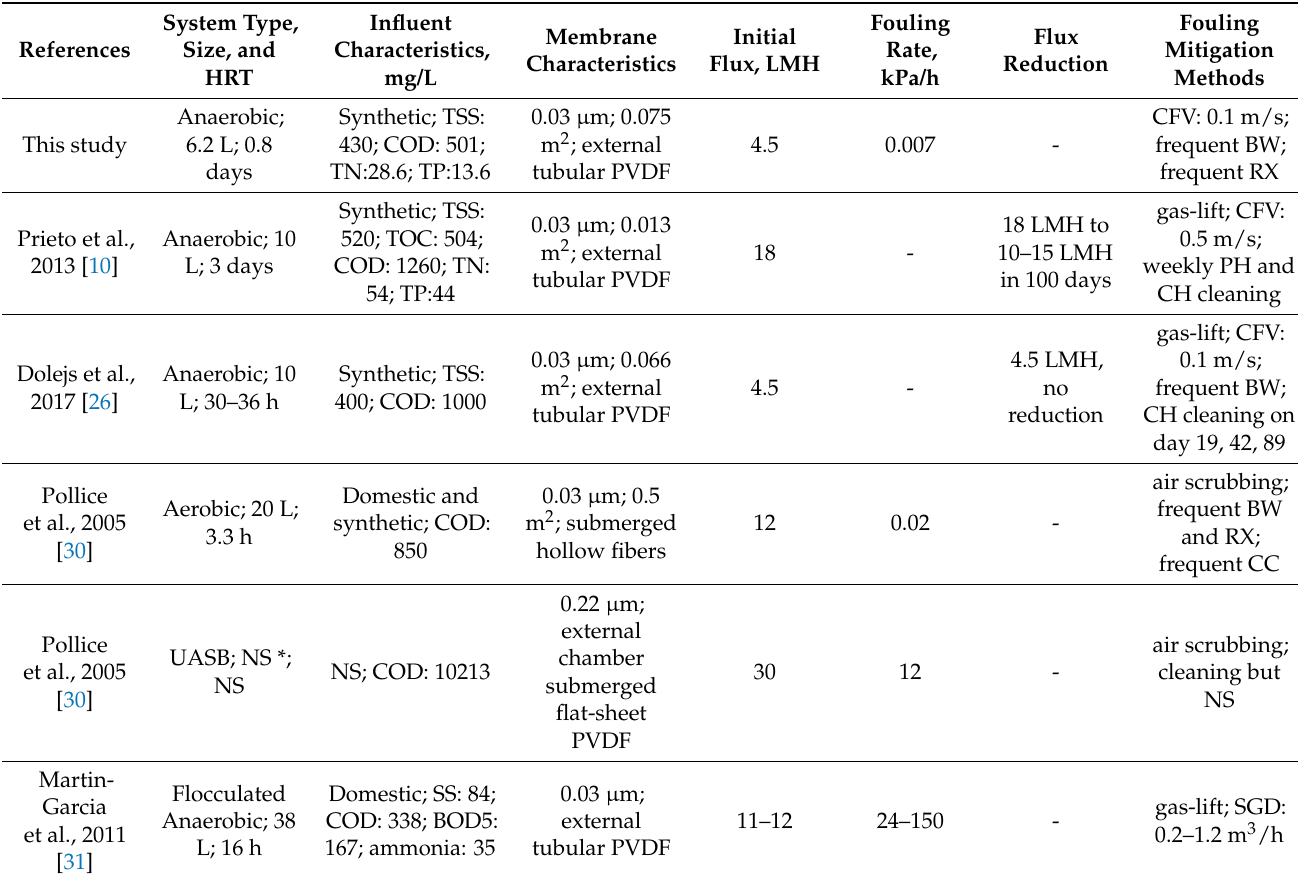
Table 1. Literature comparison between the experimental conditions and fouling results of this experiment and cited